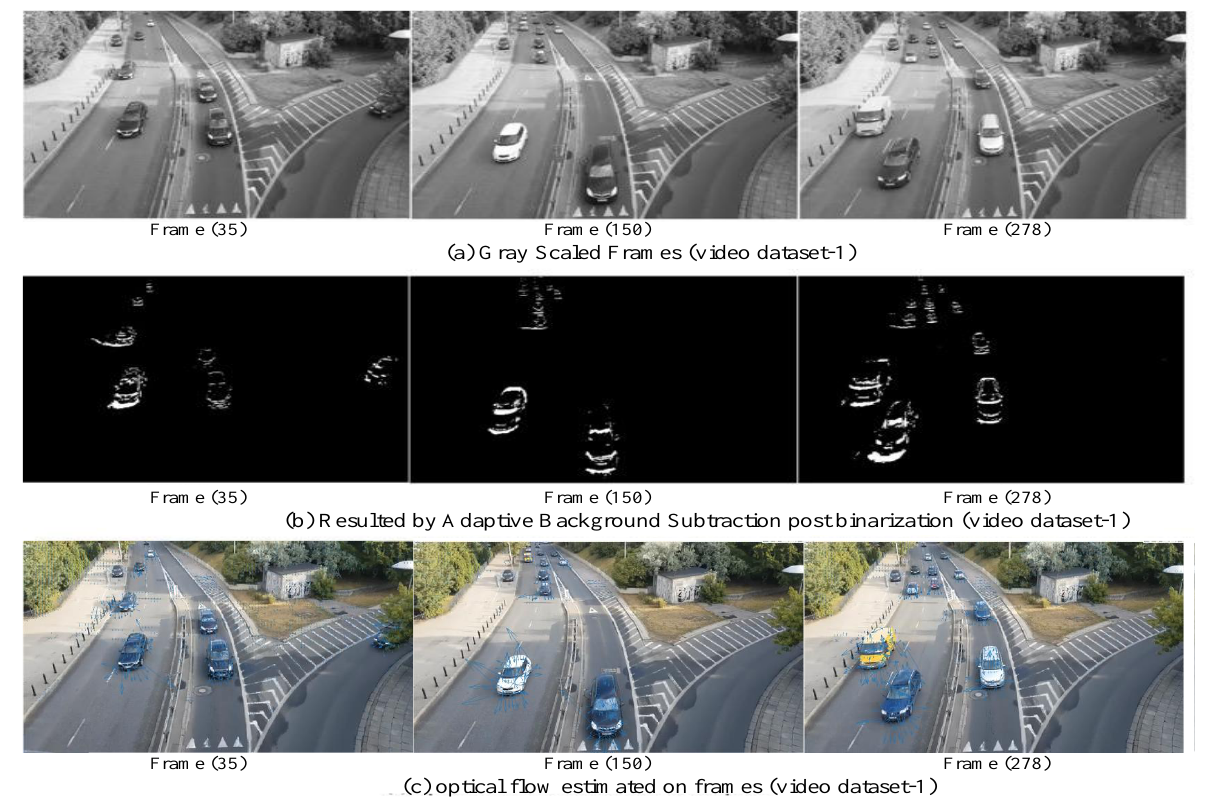
Figure 4. Simulation from video dataset 1 by the proposed framework (( a ) extracted frames in gray- scale, ( b ) foreground by adaptive background subtraction post-binarization and ( c ) optical flow).